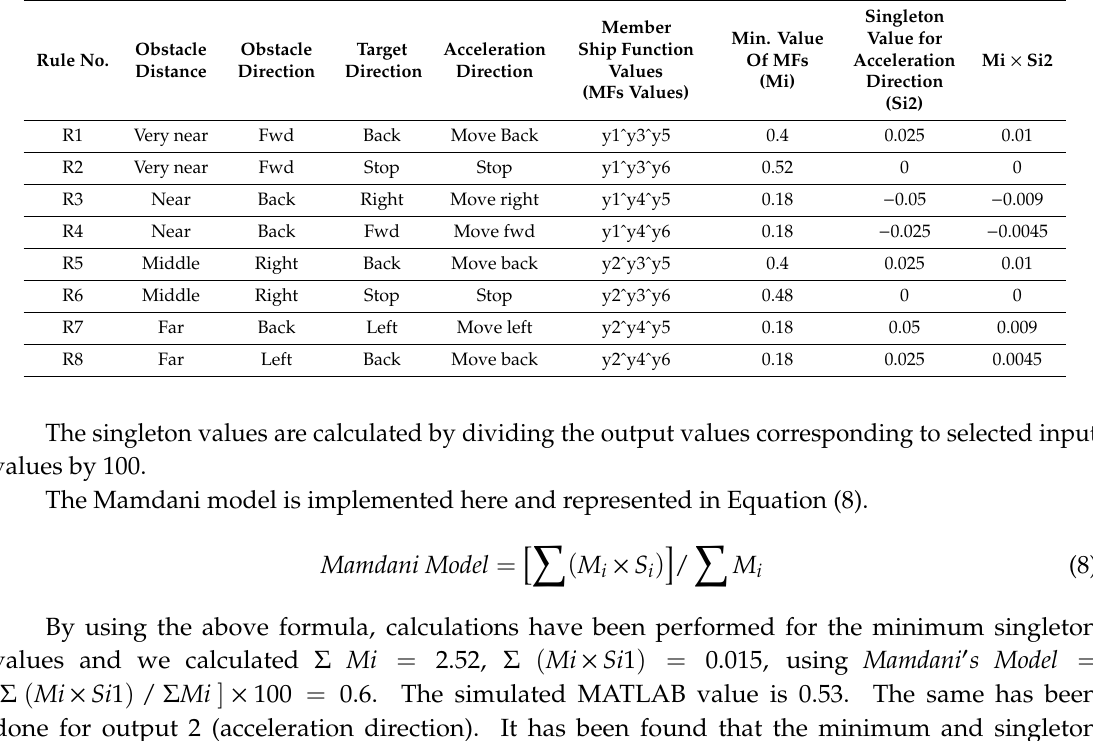
Table 2. Calculations for acceleration